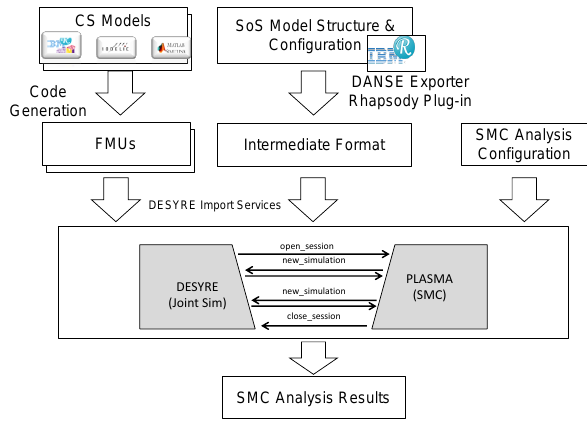
Figure 4. SMC Analysis